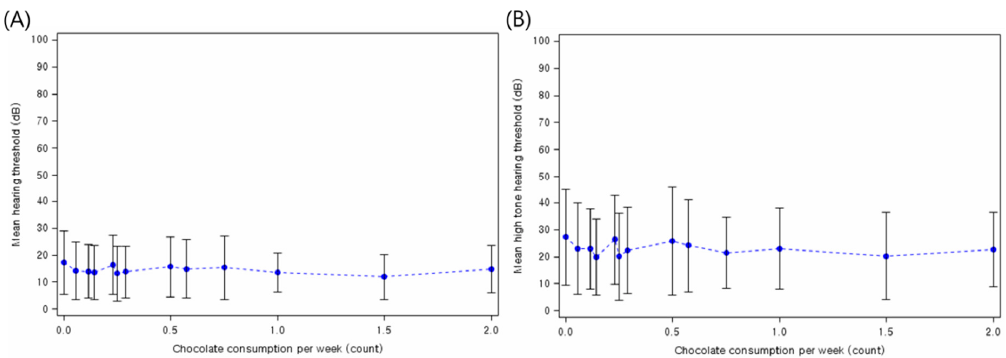
Figure 2. Scatter plot of the severity of hearing loss and the frequency of chocolate consumption per week. Chocolate consumption was inversely correlated with the ( A ) mean hearing threshold (average of 0.5, 1, 2, and 4 kHz) and ( B ) mean high-tone hearing threshold (average of 3, 4, and 6 kHz). Neither the rate of tinnitus nor the rate of tinnitus-related annoyance differed significantly according to chocolate consumption. In addition, subjects who consumed chocolate had 9% and 11% lower odds of tinnitus (adjusted OR = 0.91, 95% CI = 0.74 to 1.10) and tinnitus-related